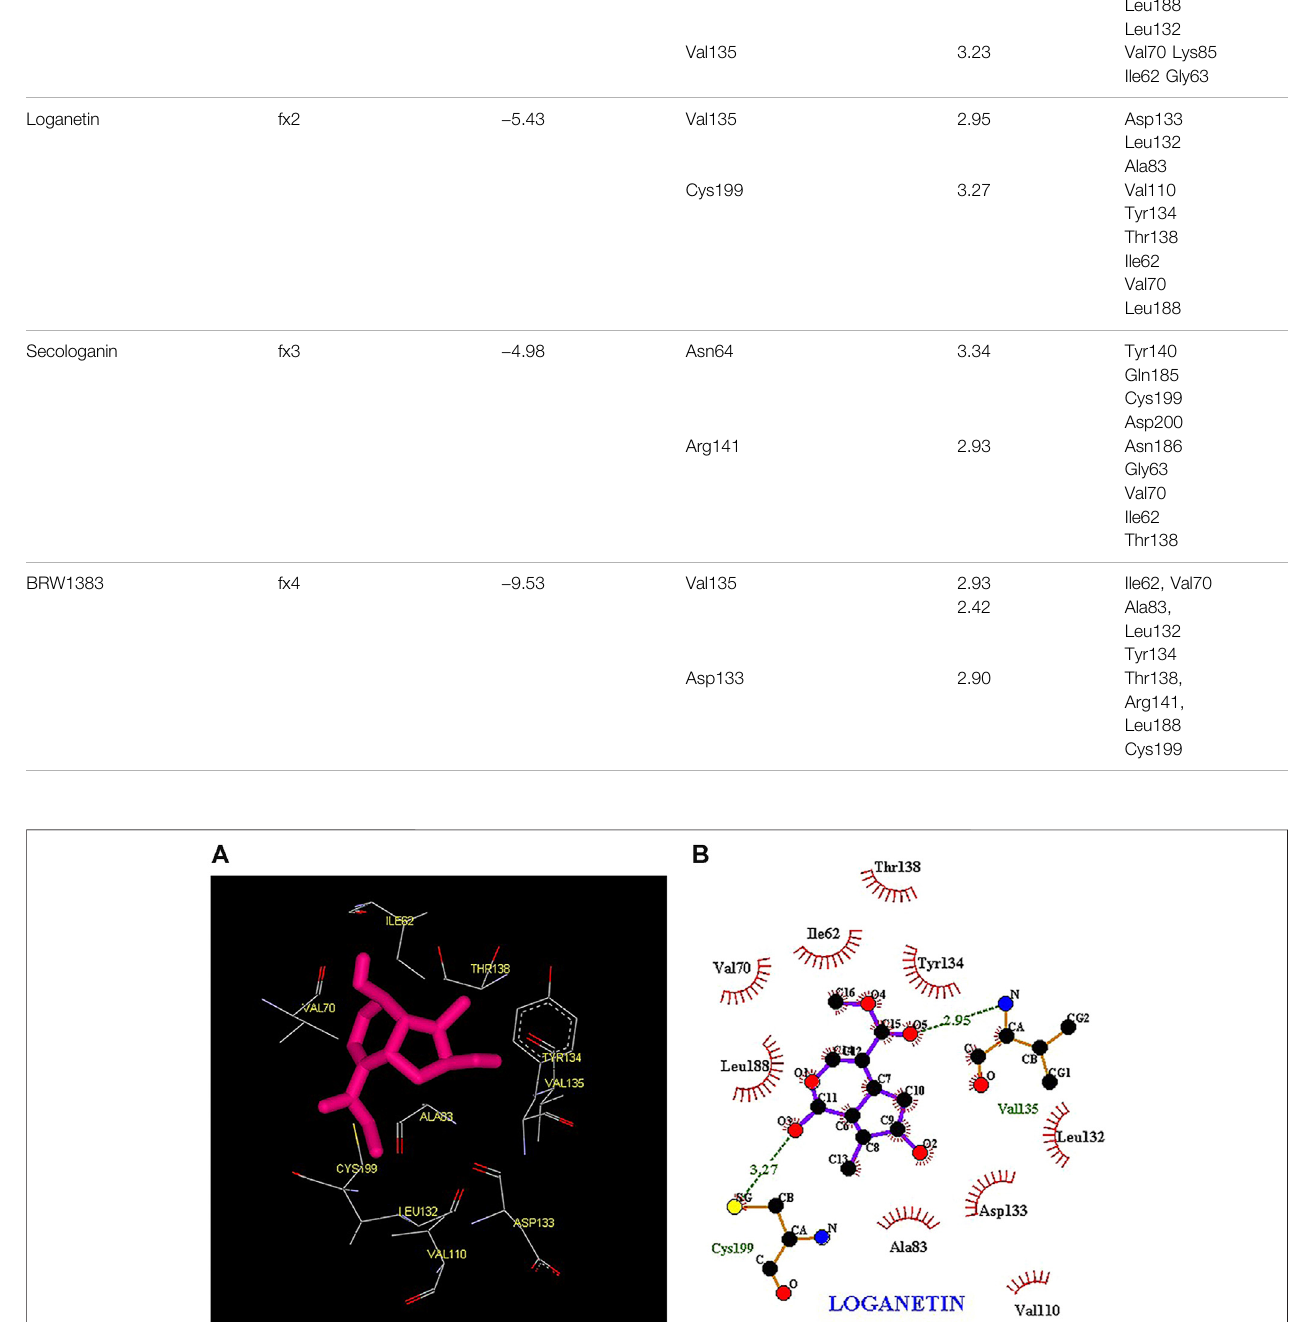
Frontiers in Chemistry |